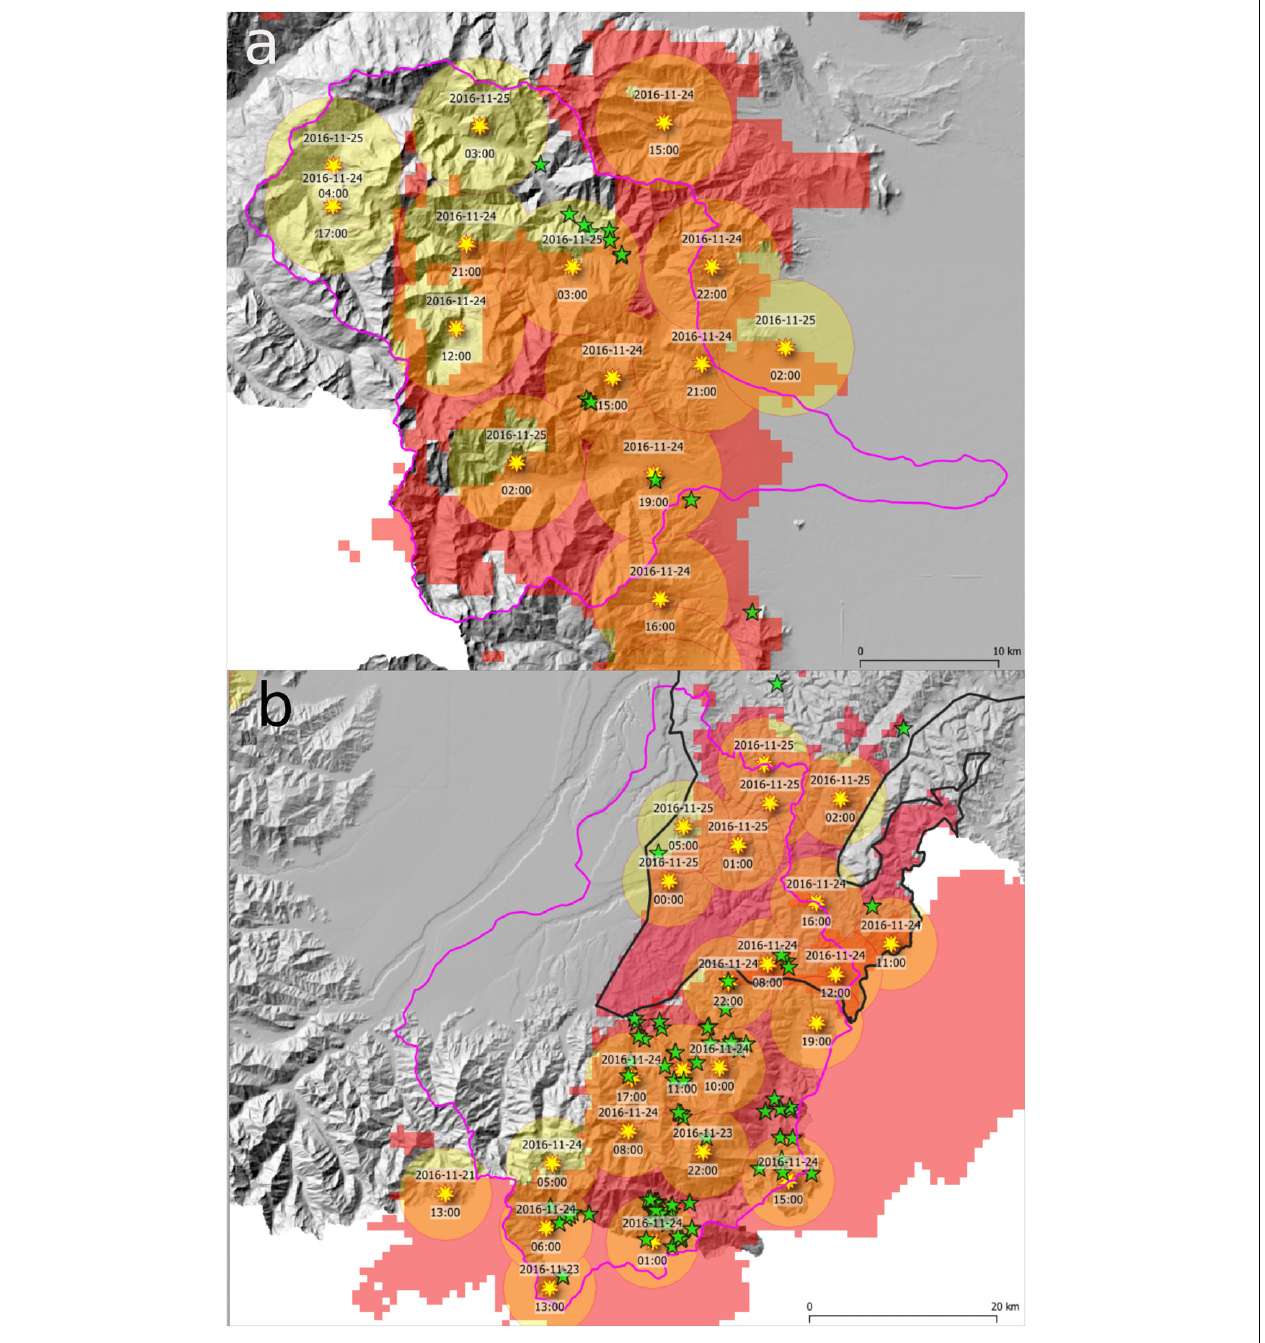
FIGURE 10 | Rainfall accumulation over Pellice-Chisone (a) and Alto Tanaro (b) basins on 25th November 2016 at 04:00 UTC. In red, areas interested by precipitations that overpassed thresholds of Equation 4 and 4 (Alto Tanaro’s hilly environment delimited by black contour) from radar estimation, rain gages overpassing threshold (yellow asterisks) and related buffers (yellow circles) from the start of rainfall event to 25th November at 04:00 UTC; green star labels indicate all the reported landslides.